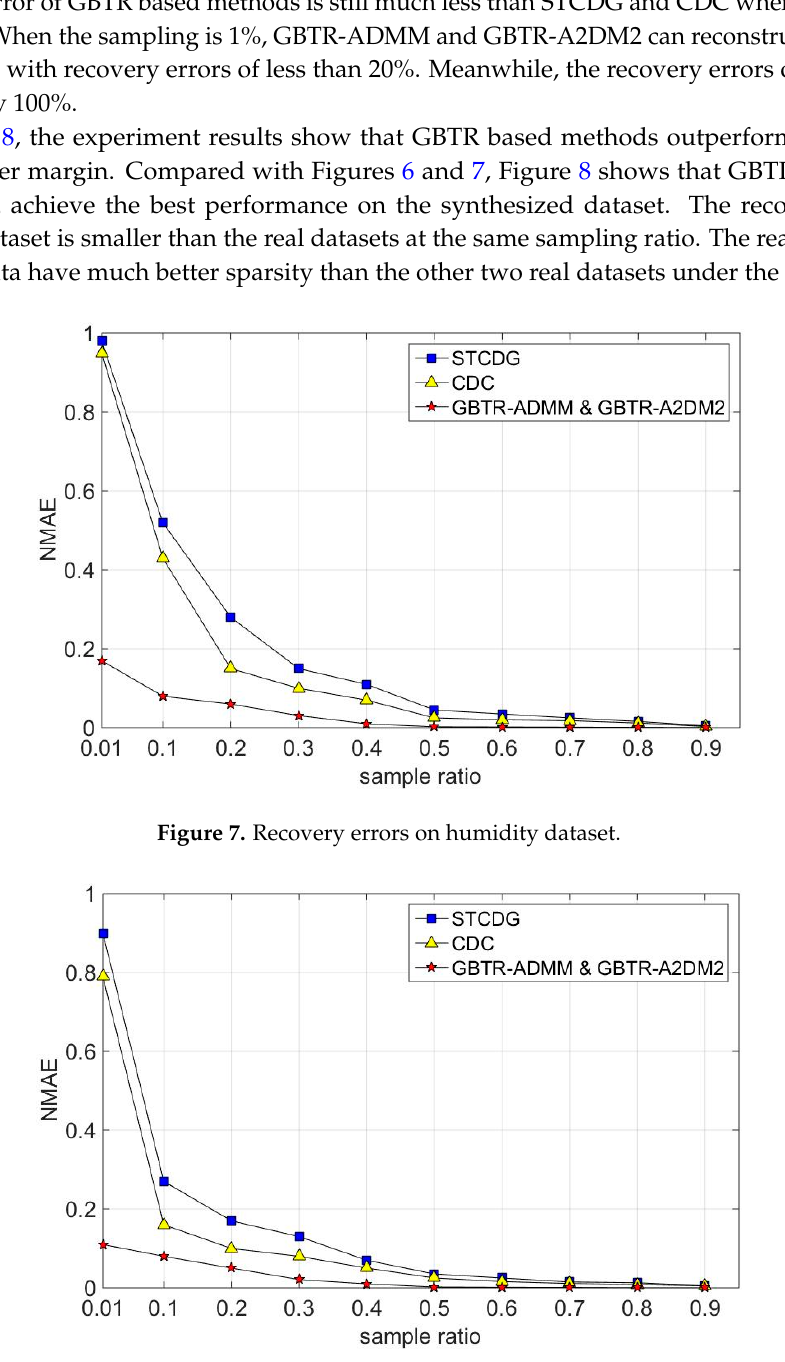
Figure 8. Recovery errors in the synthesized dataset.